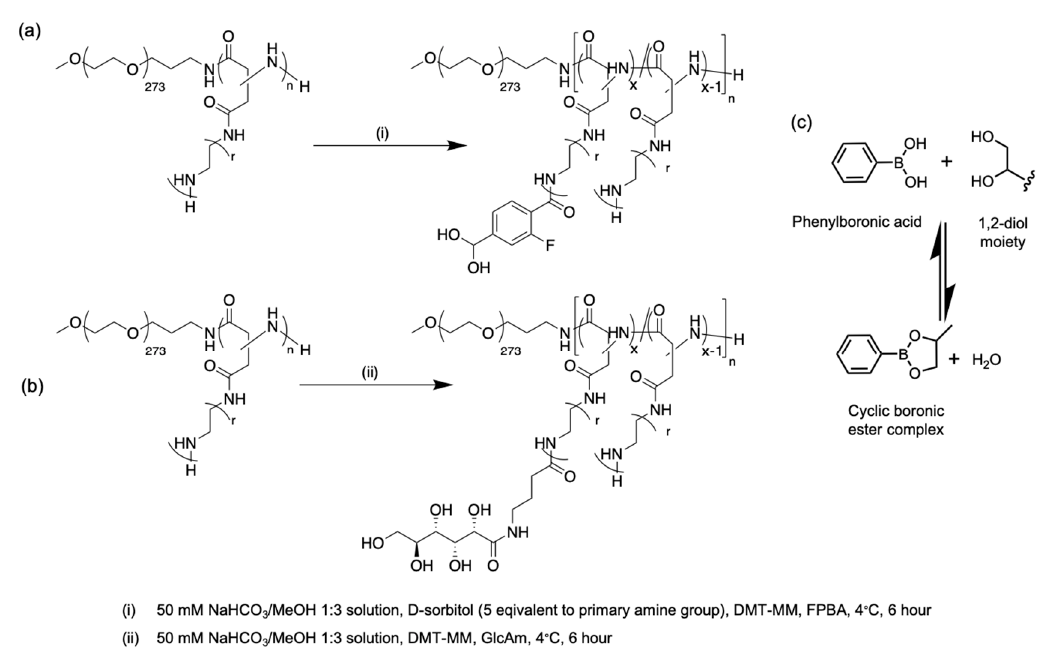
Figure 5. Scheme for installing phenylboronic acid and polyols on to PEG- b -polycations and repre- sentation of subsequent boronic ester formation/breakdown. Reaction conditions for introducing ( a ) 4-carboxy-3-fluorophenylboronic acid (FPBA) and ( b ) N -gluconamide (GlcAm) as polyol segments on polymers. ( c ) Representation of equilibrium between, formation, and breakdown of boronic ester. Recreated from [75].